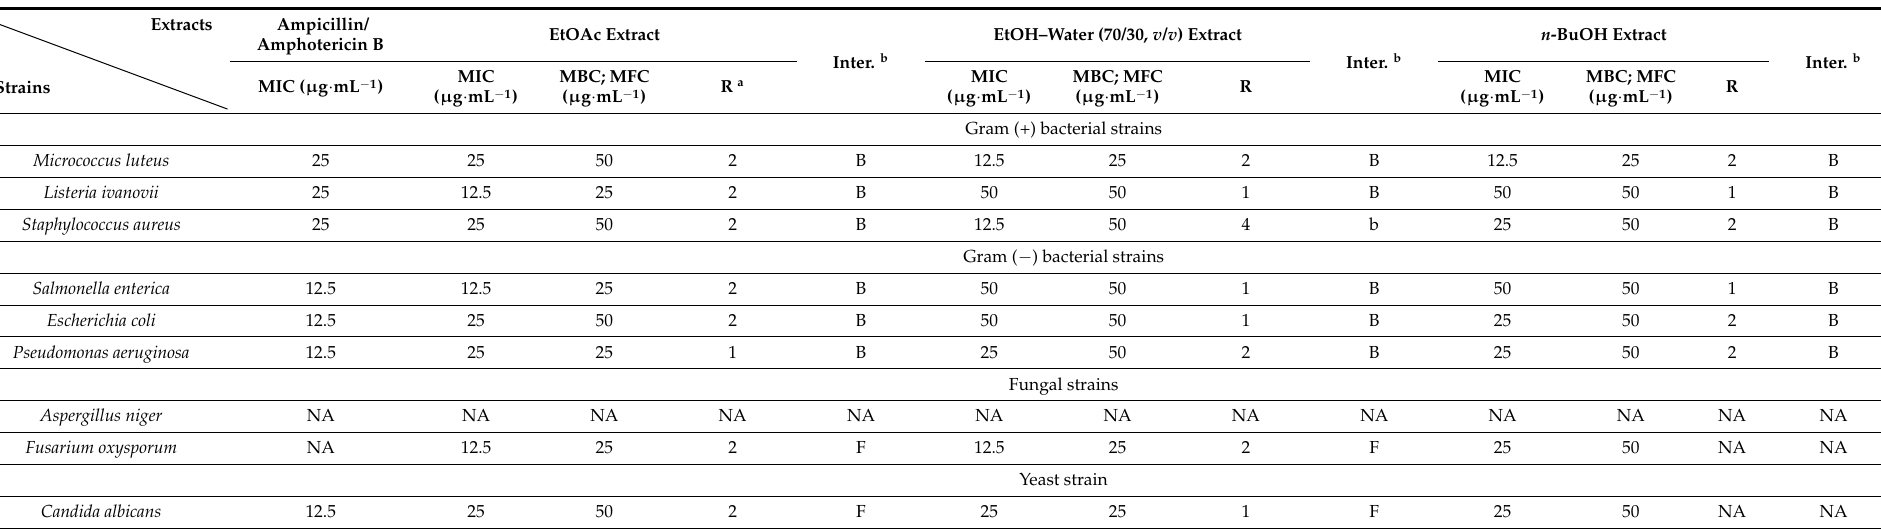
Table 6. Determination of the minimum inhibitory concentration (MIC), minimum bactericidal concentration (MBC), and minimum fungicidal concentration (MFC) of A . arboreum leaf extracts by the microdilution method. Ampicillin/ Amphotericin B